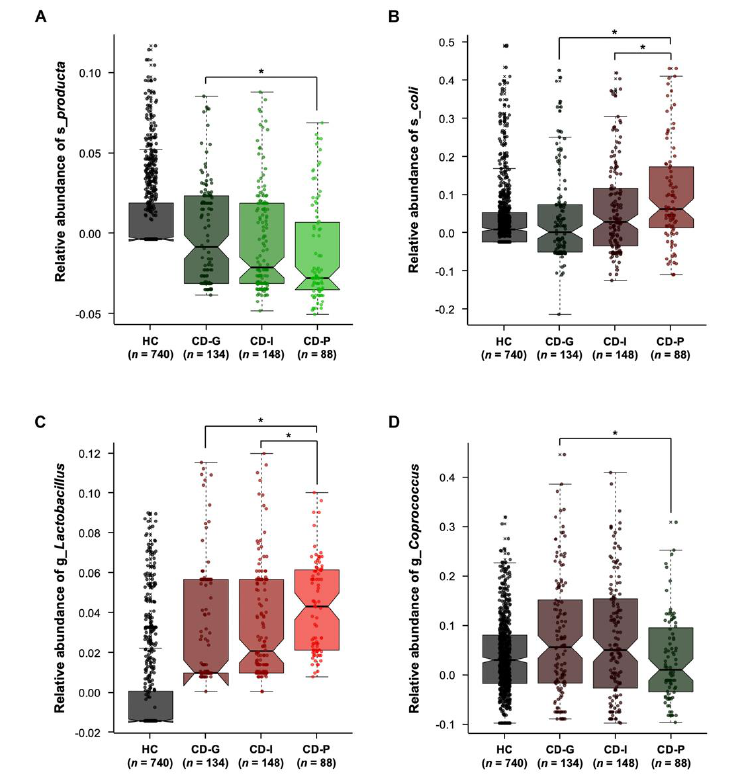
linear models using MaAsLin packages. * p < 0.05 CD-G = good prognosis group; CD-I = intermediate prognosis group; CD-P = poor prognosis group; HC = health